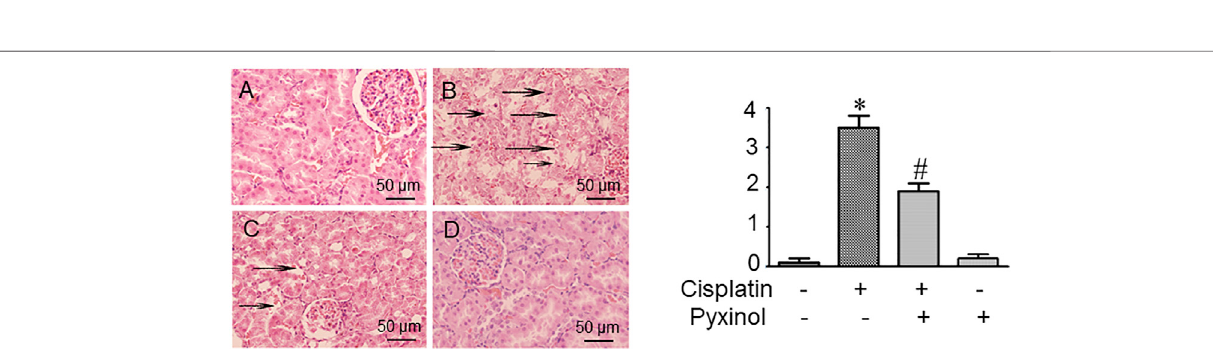
Frontiers in Pharmacology |